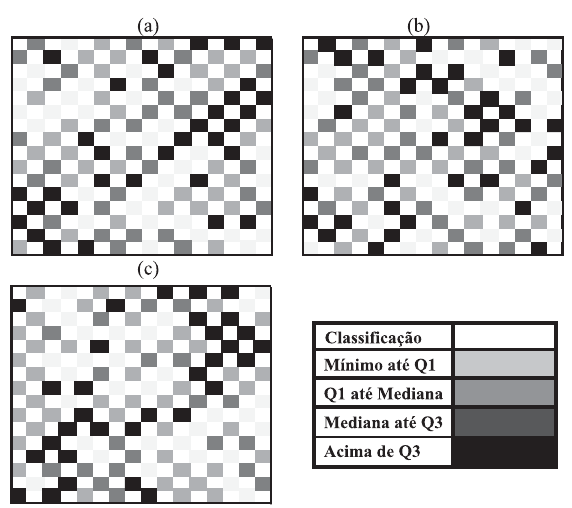
terceiro.Figura 1. Gráficos da representação espacial de área classificados segundo os quartis das variáveis Fe (a), MO (b), Mn (c) e H + Al (d), em que Q1 é o primeiro quartil e Q3 o terceiro.